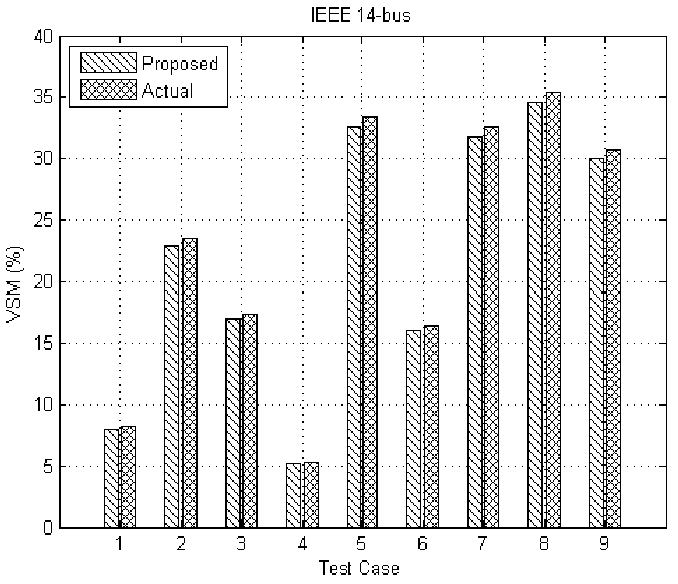
Figure 10. Estimation of system VSM for IEEE 14-bus model.